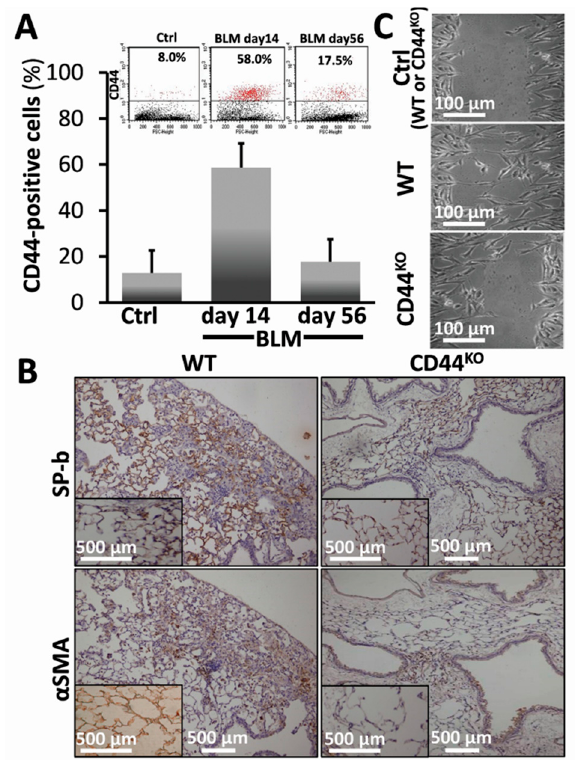
Figure 4. Bleomycin-injured chimeric-CD44 KO mice, compared to congenic-controls, decrease EMT markers in their lungs and isolated α SMA-positive cells decrease their motility phenotype in vitro. ( A ) Flow cytometry analysis (inserts) and graphical presentation of CD44 expression in myofibroblasts isolated from C57BL/6 mouse lungs at 14 days (acute fibrosis), and 56 days (tissue regeneration) following bleomycin injury vs. normal-saline control. p < 0.05. ( B ) Surfactant-b epithelial cell marker (SP-b) and mesenchymal/myofibroblasts cell marker ( α SMA) staining in lung tissue sections from C57BL/6 WT vs. chimeric-CD44 KO mice at day 14 of bleomycin and control-saline (inserts). Representative of 4-5 sections in 3 separate experiments with similar results, n = 7–10. ( C ) Injury assay of motility. Cells were cultured in medium containing 0.5% BSA and 20% FCS, for 72 h up to 50–70% confluence. The cells were scratched with a pipette tip, washed with PBS. The wounded areas were further cultured in starvation medium 0.5% FCS for additional 24 h. The images of cell recovery and migration were taken under phase contrast microscope. Performed by TIMNA